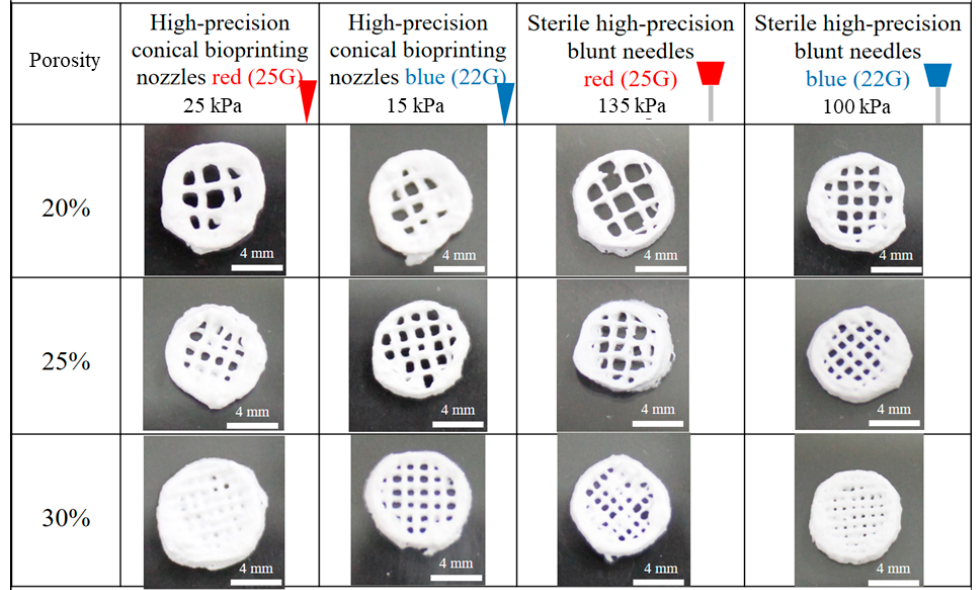
Figure 1. FTIR spectra of pure hyaluronic acid and oxidized hyaluronic acid (OHA).